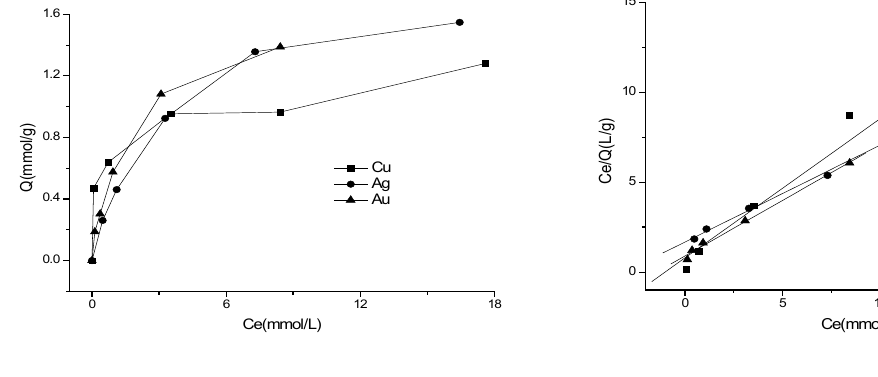
Figure 6. The Langmuir isotherms of the sample SG-PS-azo-SA for Cu(II), Ag(I) and Au(III)